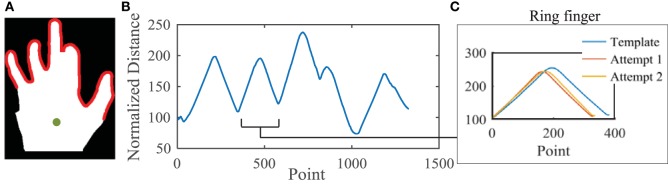
Image analysis procedure. (A) Preprocessing of the raw image results in a binary figure with the wrist cutoff. The portion being analyzed includes only edges pertaining to digit edges (highlighted in red). The distance between the figure centroid (green) and digit edges is calculated and normalized (B). (C) Each finger is separated using peaks and valleys. Here, the ring finger has been separated out. The Euclidian errors between template and entry distances are determined for each finger.